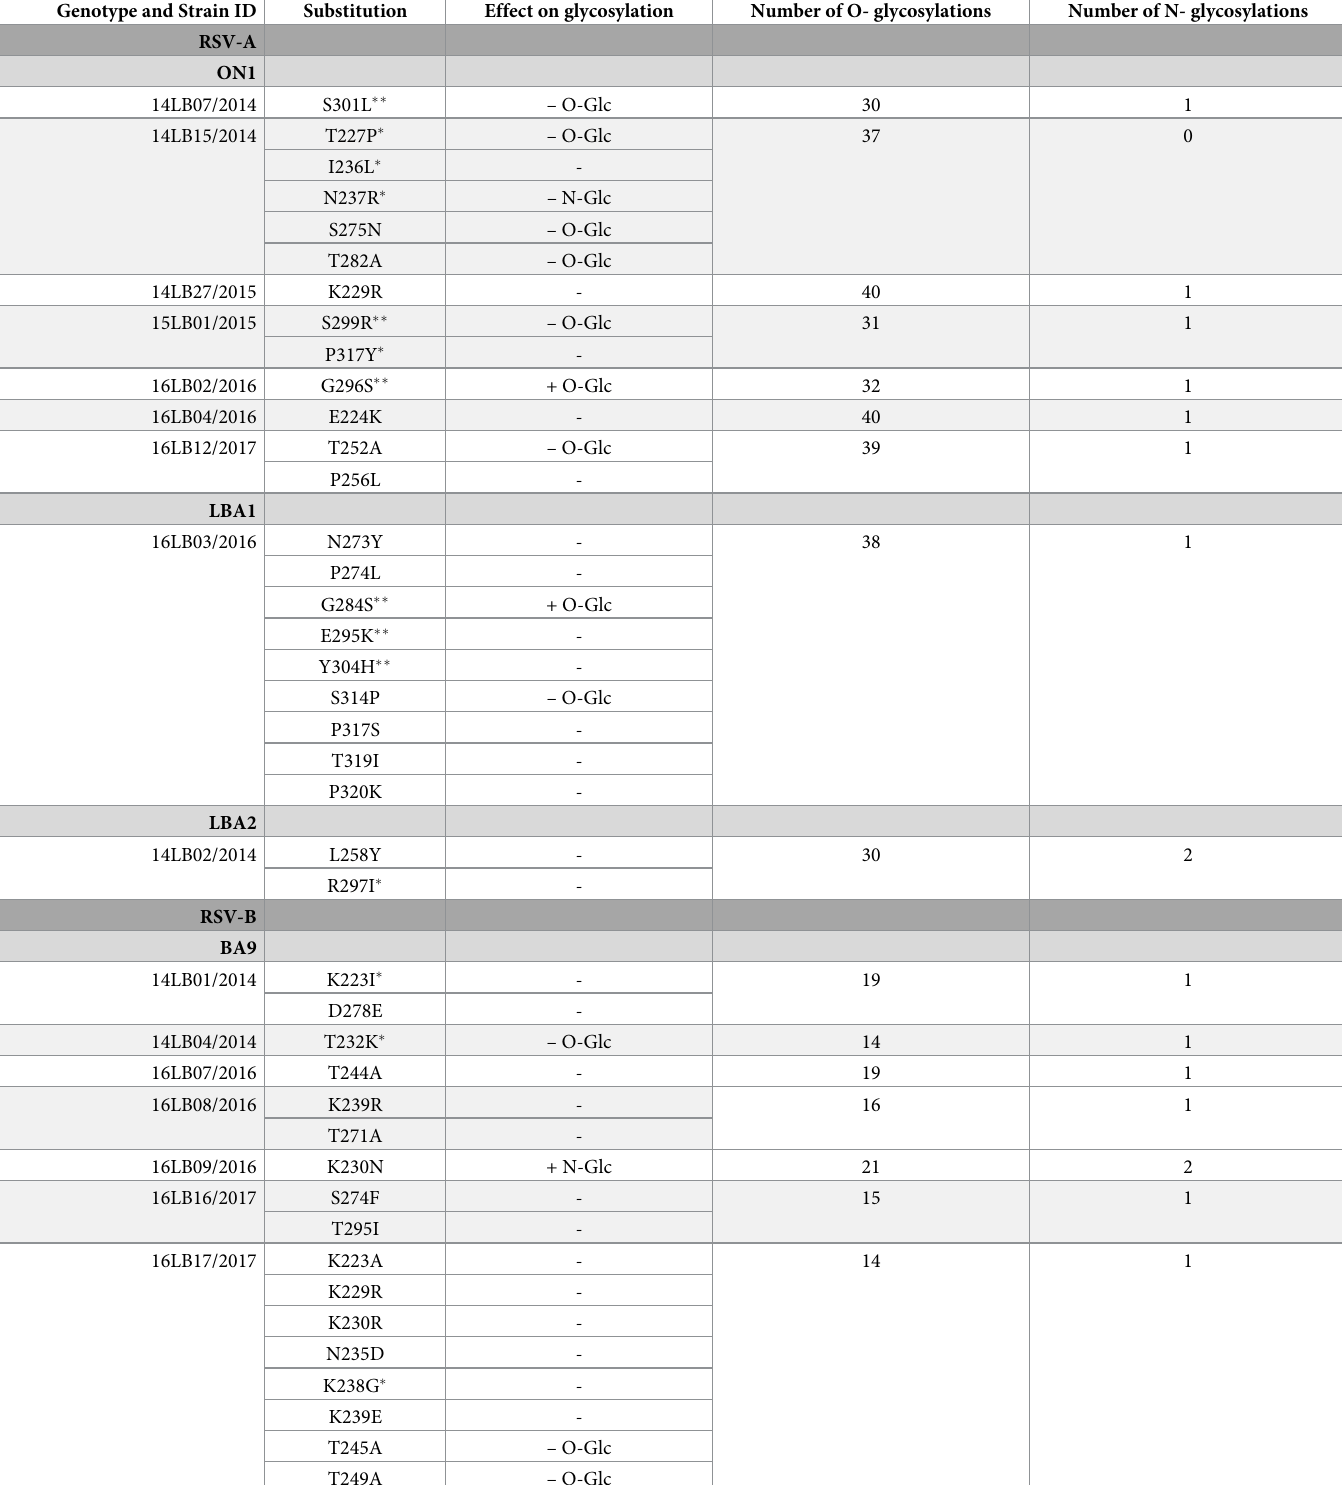
Table 2. Representative Lebanese specimens with G protein substitutions and their predicted effect on